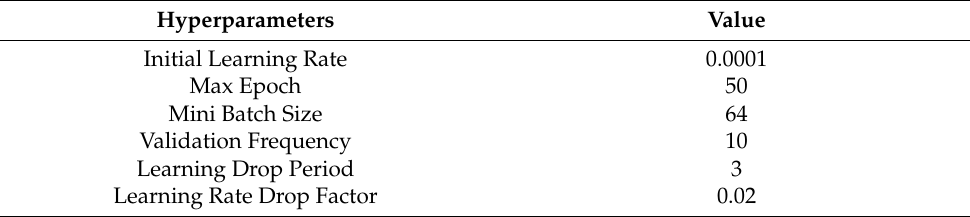
Table 5. Hyperparameters in CNN